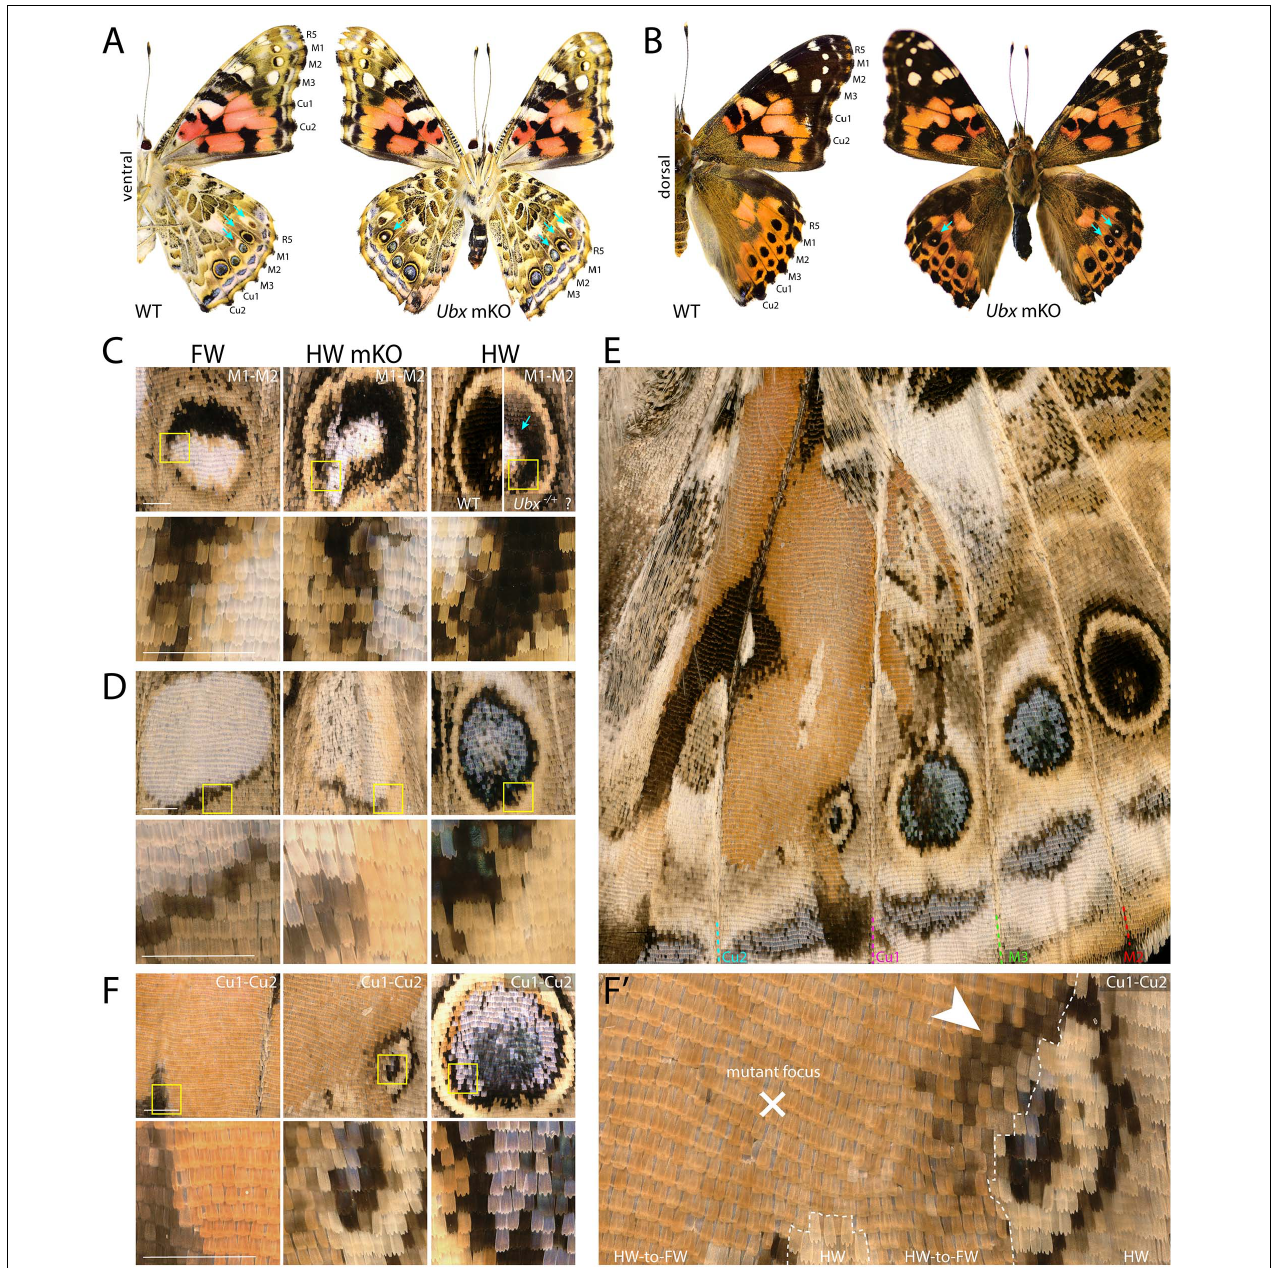
FIGURE 4 | Dominant-white, partial and complete replacement, and large truncation effects on Vanessa eyespots. (A,B) Ubx mKO individual with multiple hindwing eyespots showing ectopic white. White scales are prominent in the three WT forewing eyespots between R5 and M3, but normally absent from hindwings (arrows). (C) Magnified views featuring two mutant M1–M2 eyespots from panel A; center: homeotic transformation of the left side, the rest of the eyespot may be heterozygous-mutant due to the forewing-like white center; right: comparison of a putative heterozygous mKO and WT (uninjected) eyespots. (D) Complete homeosis of an M2–M3 eyespot. (E–F’) Views at increasing magnification of truncated Cu1–Cu2. Most of the eyespot field is transformed, but unaffected tissue left an eyespot remnant that likely deployed its own signaling activity, as the partial induction of black rings in the mutant field implies (arrowhead). Panels (A,C–F’) : ventral views. Scale bars = 500 µ